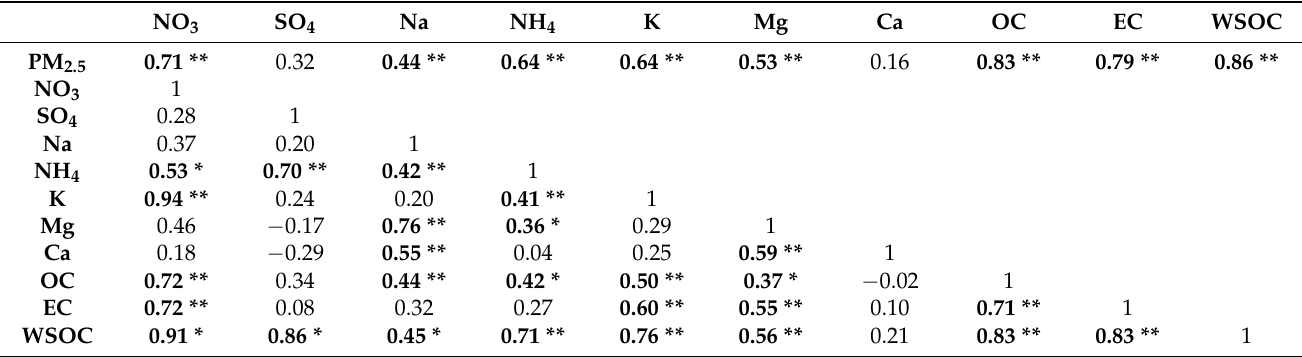
Table 4. Pearson correlation coefficients between PM 2.5 components in HC samples. Number in bold with two starts and with one star indicate that the correlations were significant at the 0.01 and 0.05 levels, respectively.